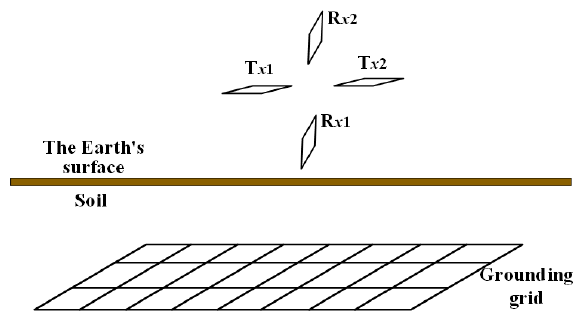
Figure 3. A simulation model of the four-coil structure.